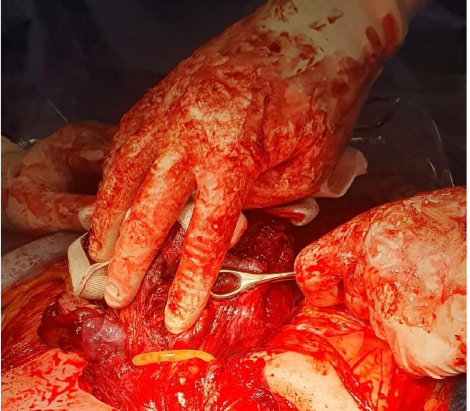
Figure 7. Placement of a Foley catheter as a tourniquet to prevent hemorrhage.